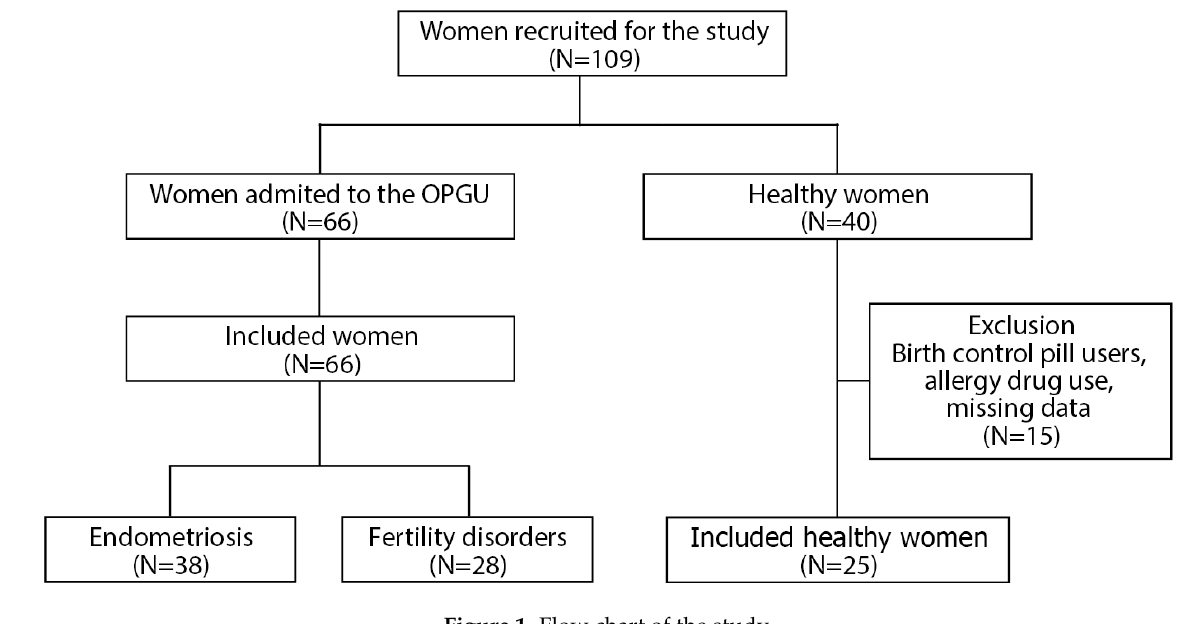
Figure 1. Flow chart of the study. Table 1. Characteristic of the study